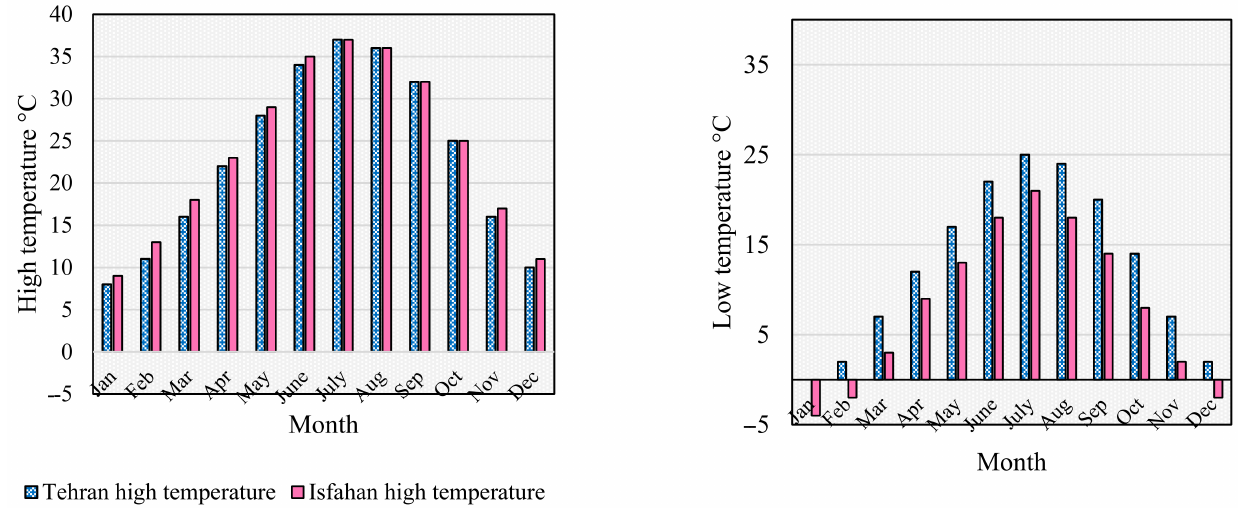
Figure 26. Temperature comparison between Tehran and